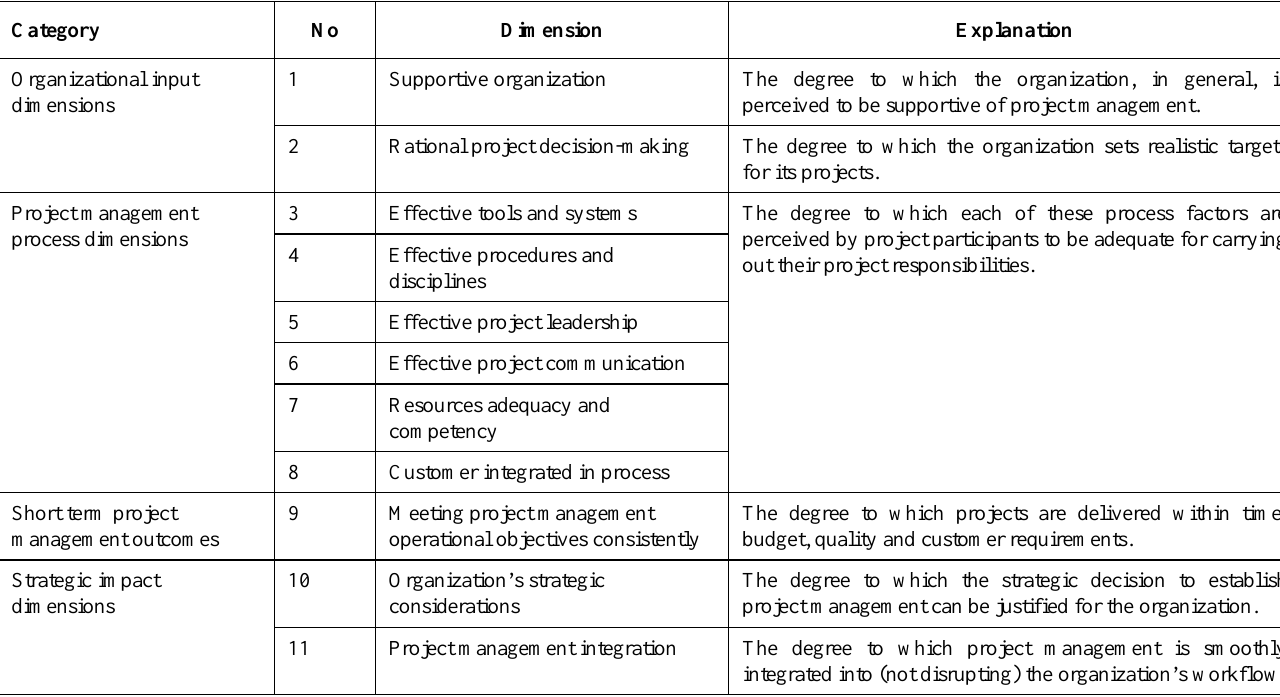
Table 2: Definition of the project management effectiveness